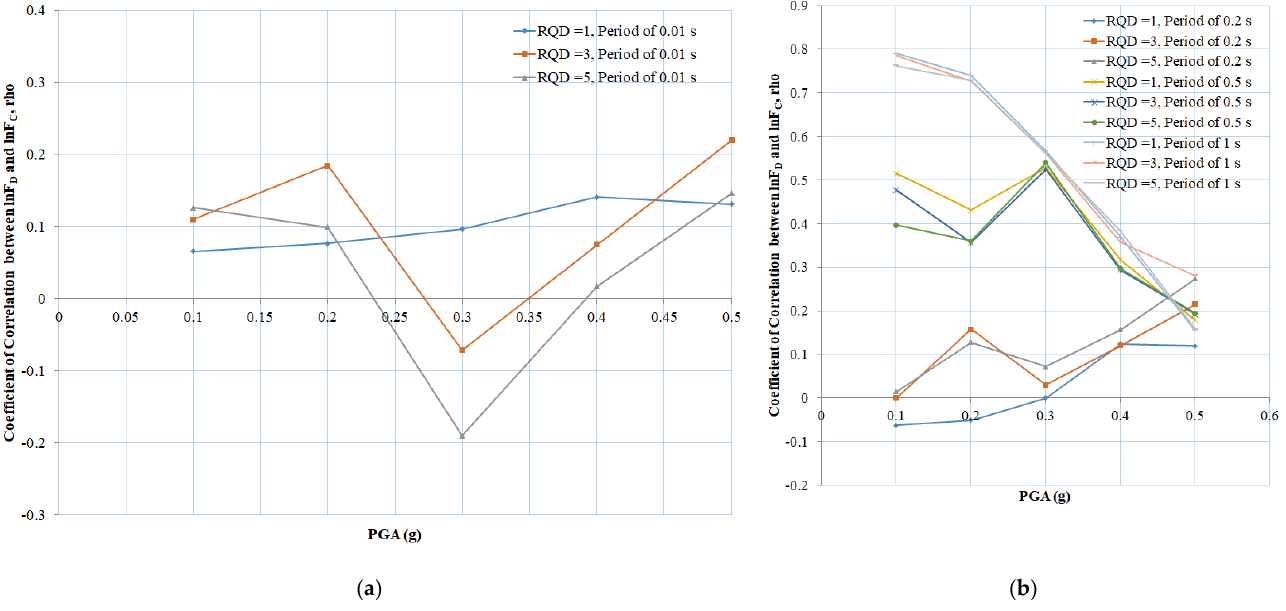
Figure 17. Correlation coefficient between lnF D and lnF C as a function of PGA and RQD ( a ) for a period of 0.01 s, ( b ) for periods of 0.2, 0.5 and 1.0 s.